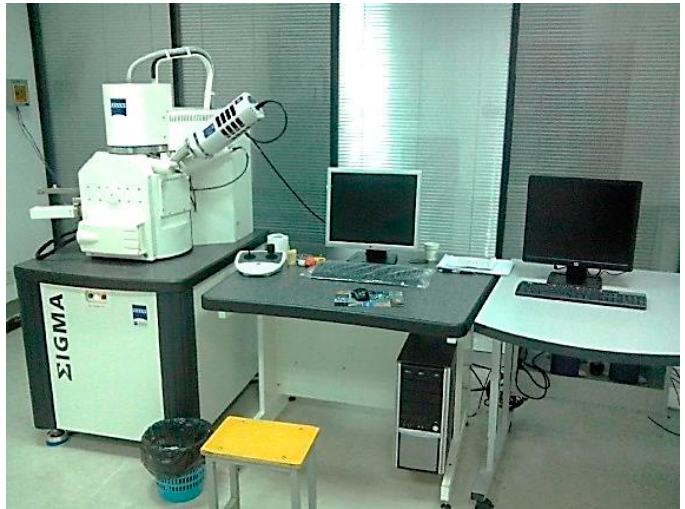
Figure 3. The Σ IGMA SEM.